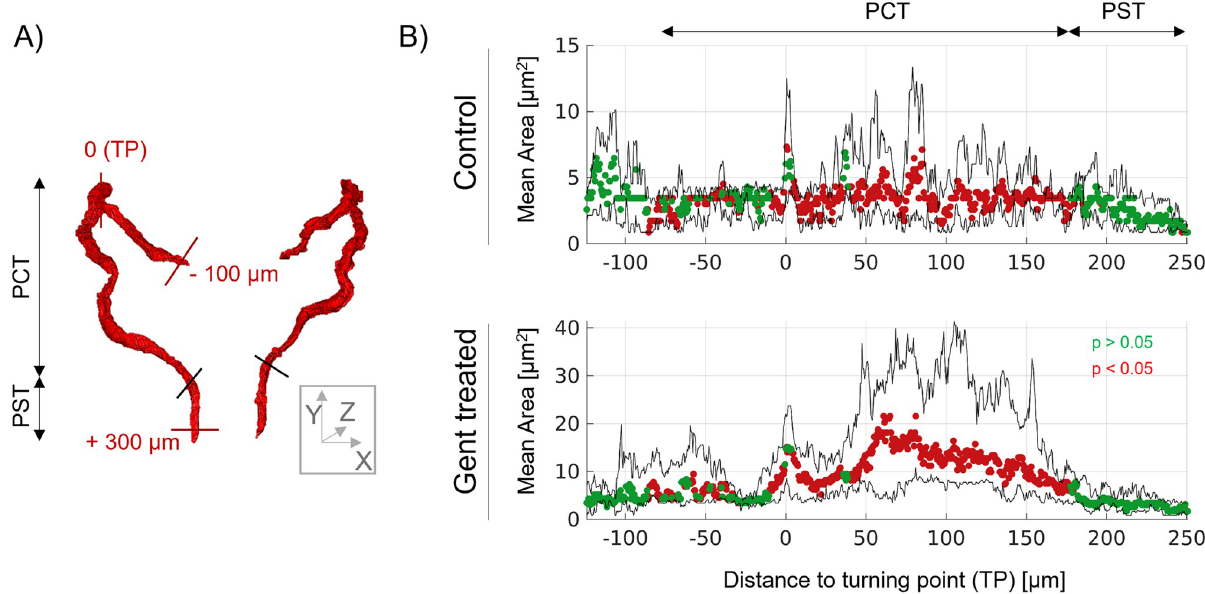
Fig 6. Localization of gentamicin-induced tubular damage. (A) Rendered renal tubules are divided into PCT and PST. Distances to the turning point (TP, defined as zero) are indicated in the direction of the glomerulus (negative values) and towards the cloaca (positive values). (B) The plot of tubule cross-section area against distance from TP. Gentamicin treatment: 1 nL of 42 mM gentamicin, analysis 24 hpi injection. Symbols: mean cross-sectional area, color coded with respect to significant differences between control (n = 4) and gentamicin (n = 8) treated ZFL. Green symbols: p > 0.05. Red symbols: p <